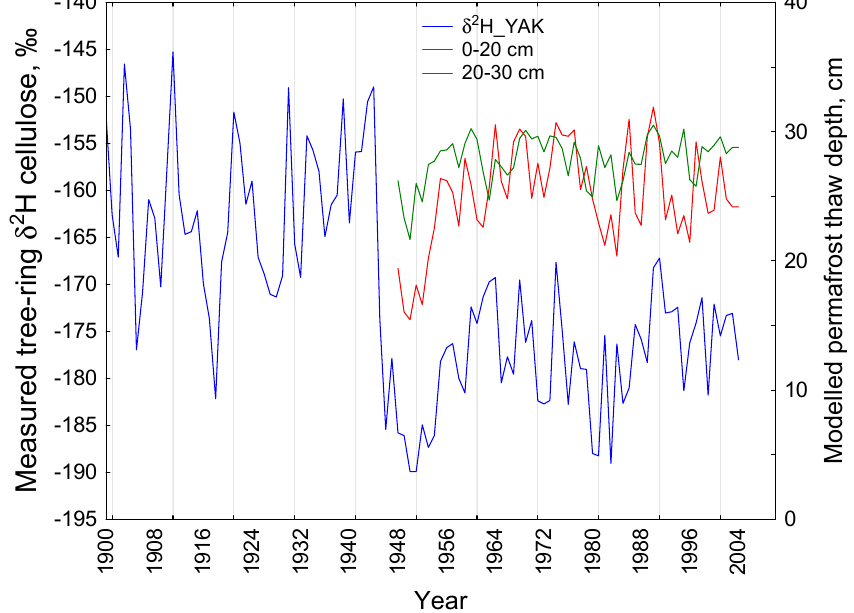
Figure 4. Measured δ 2 H from YAK (this study) versus modelled water fraction at different permafrost thaw depths, 0–20 and 20–30 cm [50].